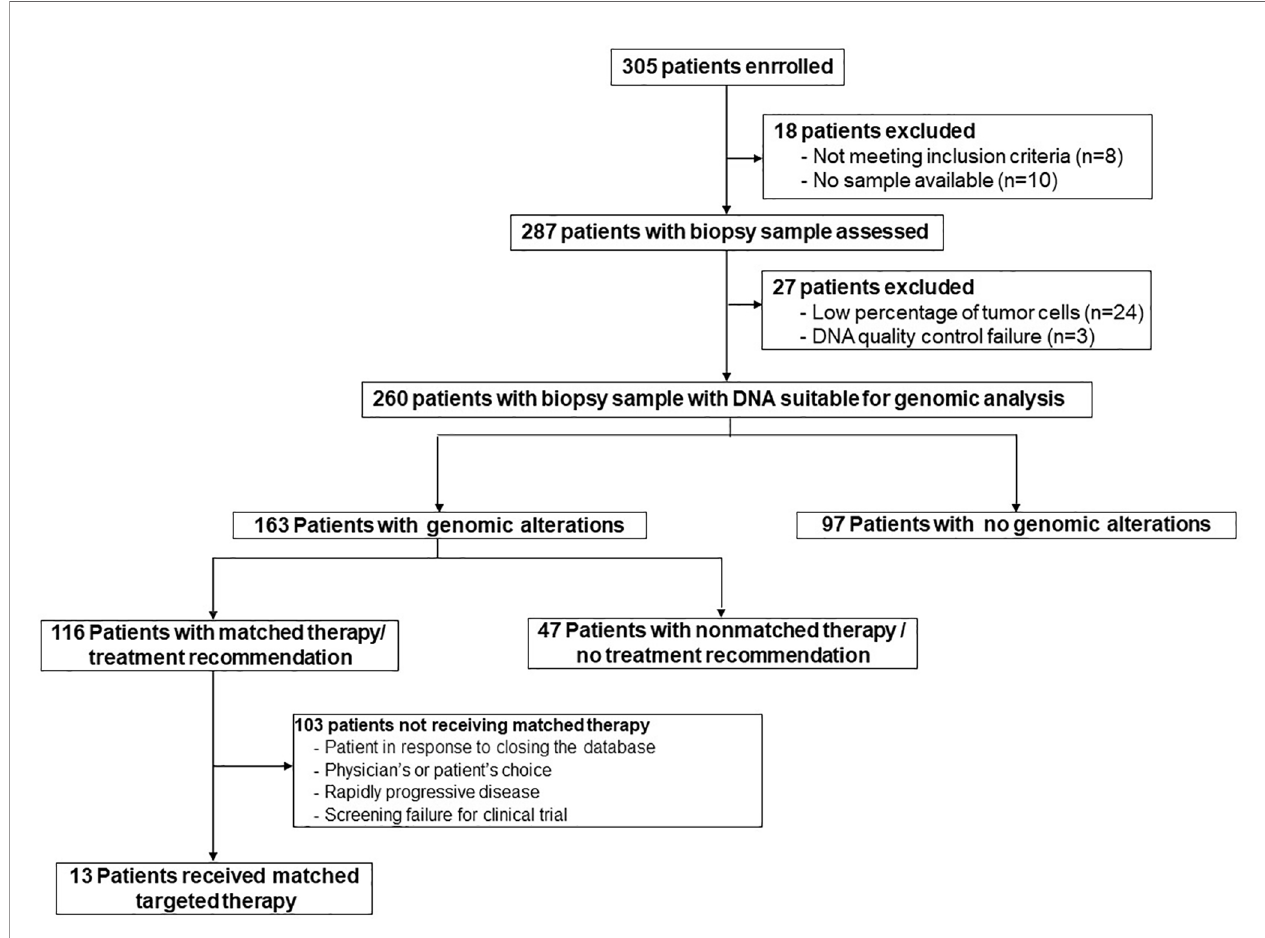
FIGURE 1 | Flow chart of the SOLTI-1301 AGATA